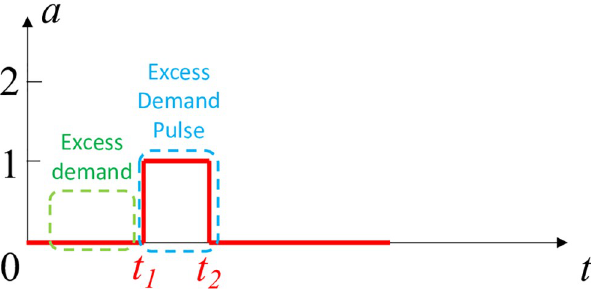
Fig 2. This bike availability curve indicates possible excess demand for t 2 (0, t 1